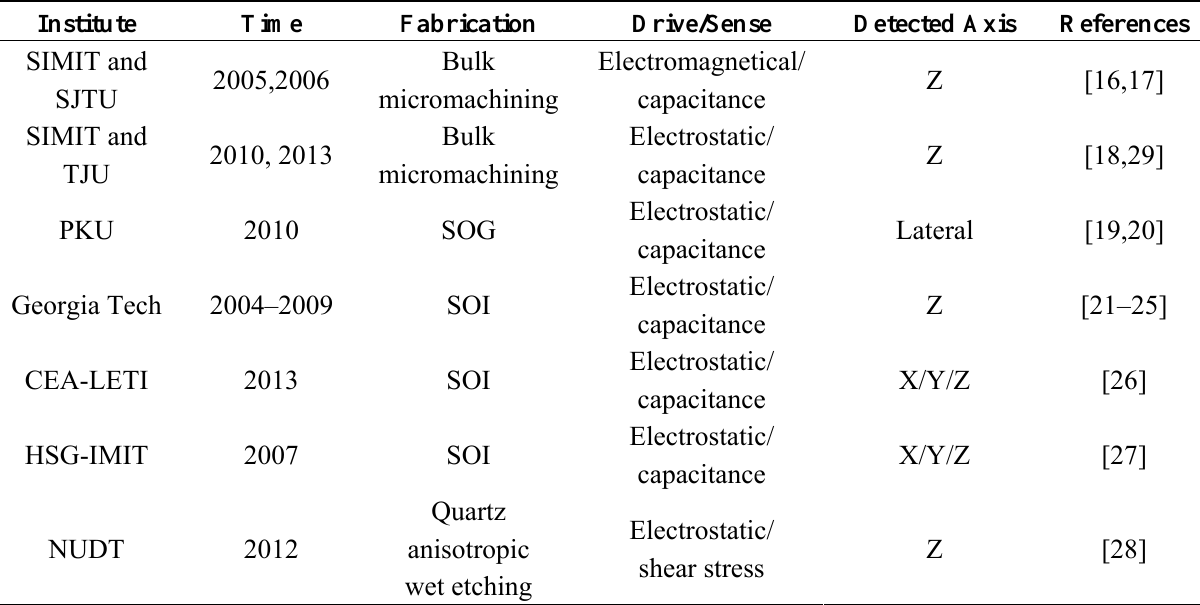
Table 2. The summary of